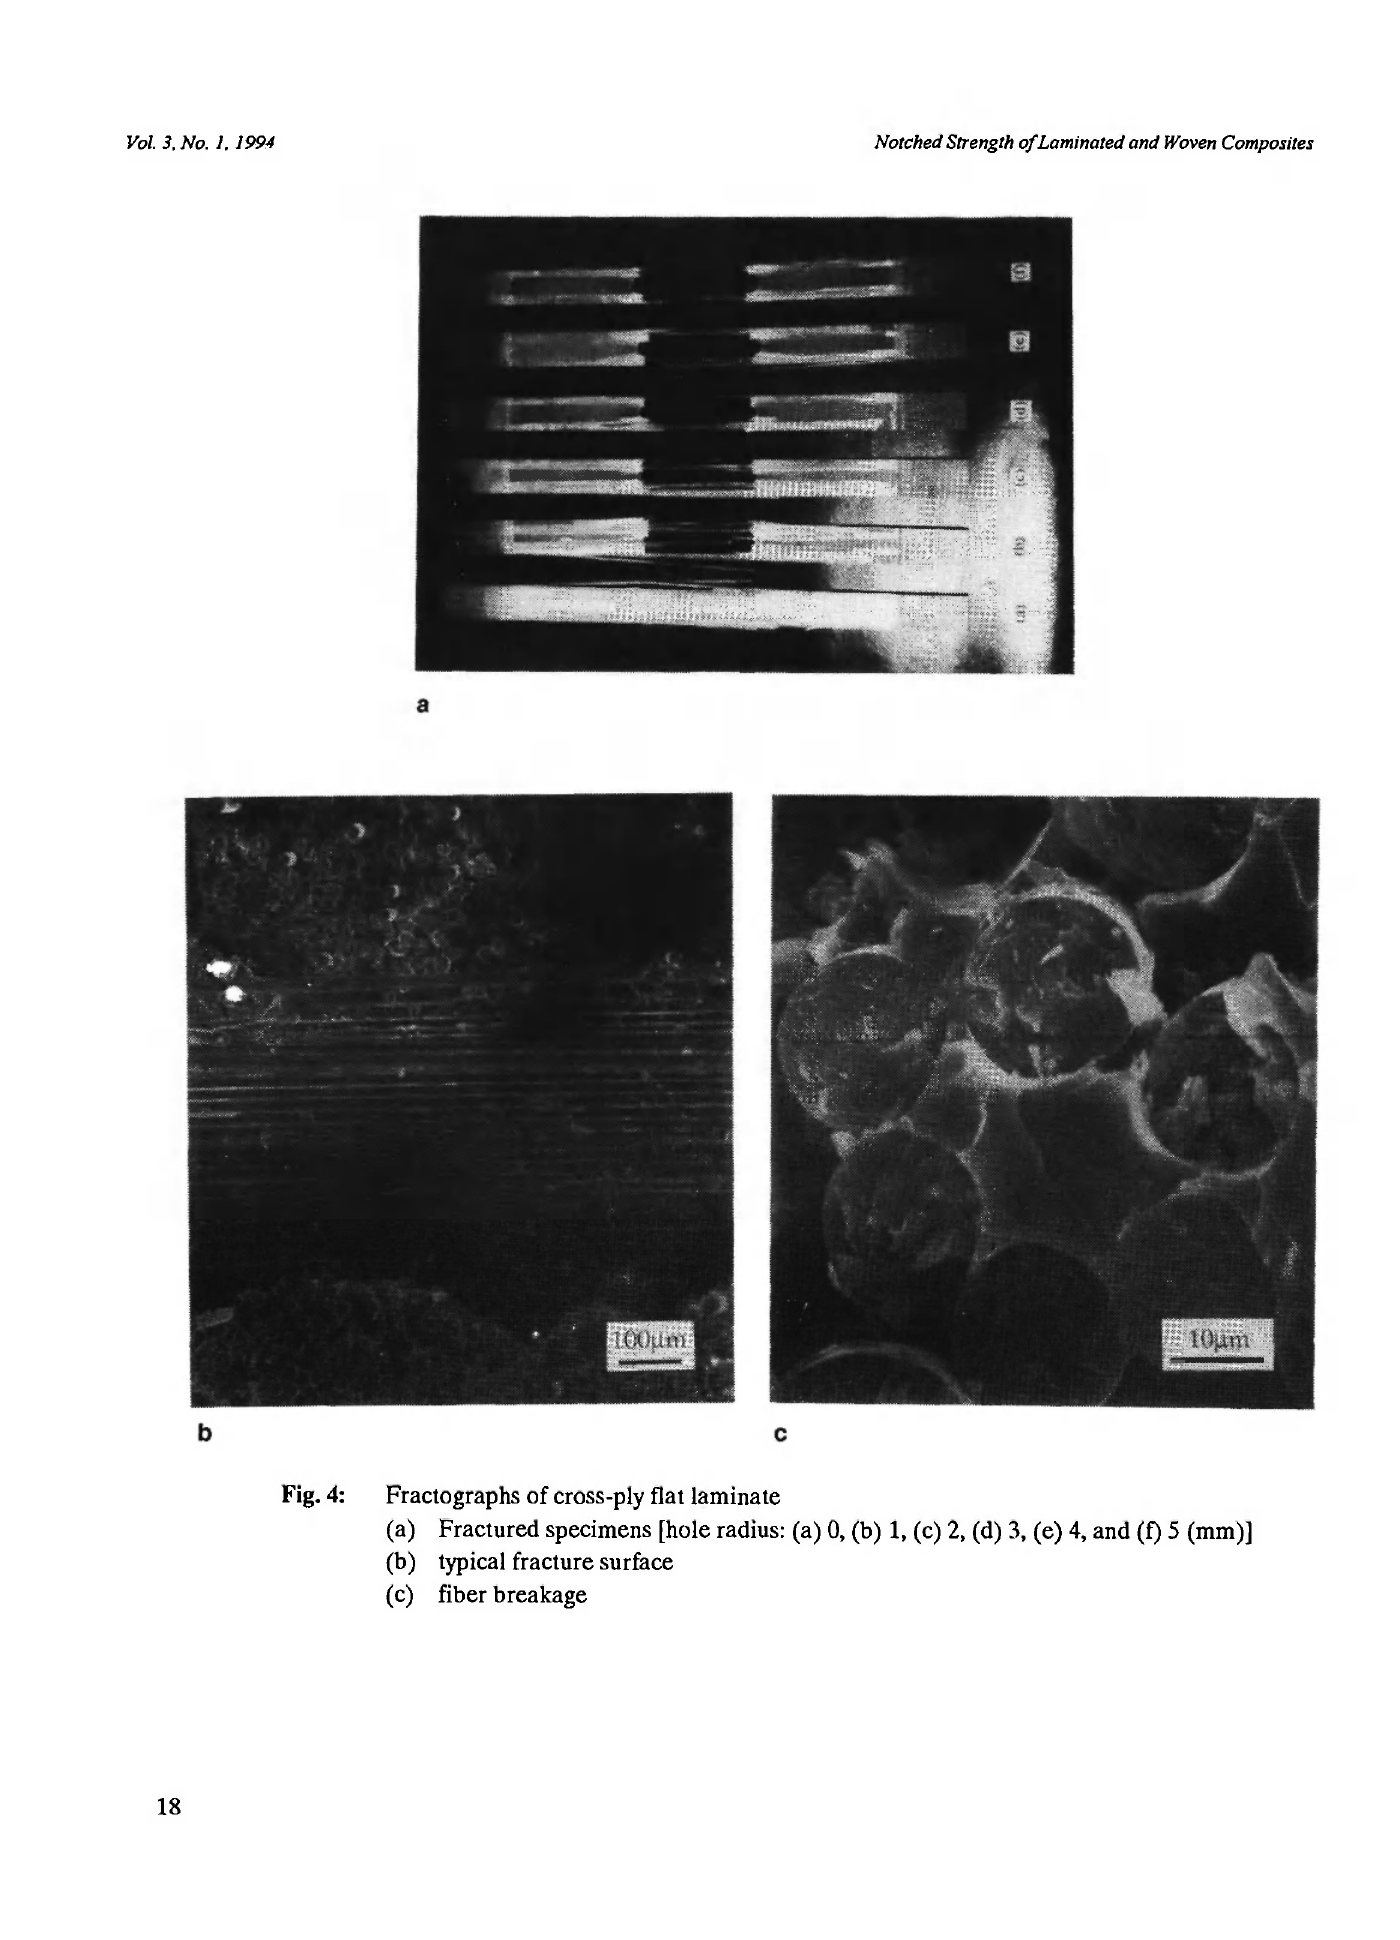
Fig. 4: Fractographs of cross-ply flat laminate (a) Fractured specimens [hole radius: (a) 0, (b) 1, (c) 2, (d) 3, (e) 4, and (f) 5 (mm)] (b) typical fracture surface (c) fiber